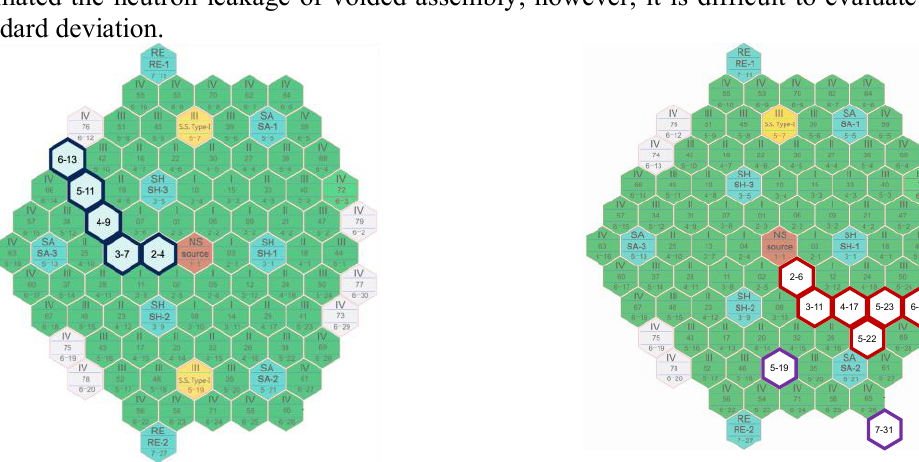
Figure 6. Positions and Void FA Loading for Void Reactivity Measurement.